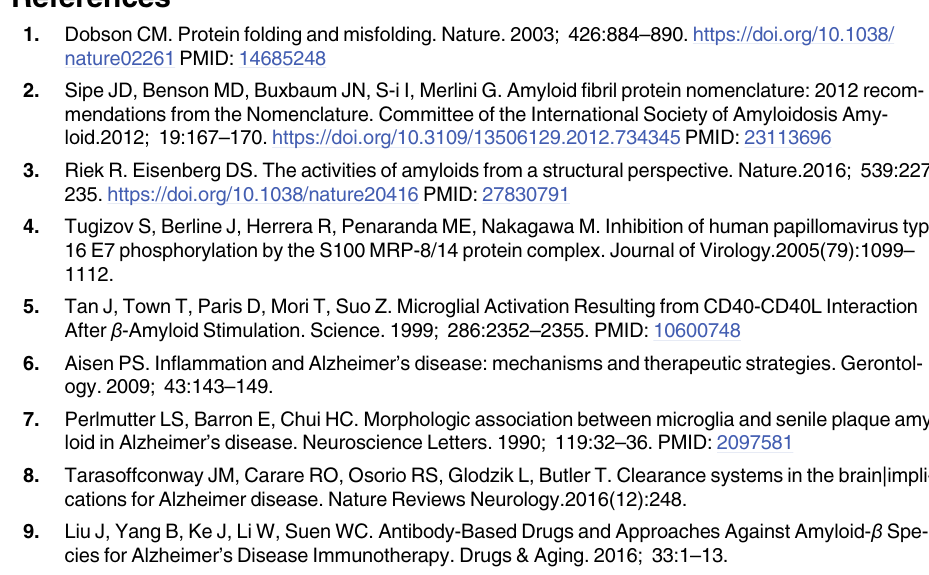
culture medium (left), 400 μ M OA (middle), and 4 μ M HEWL and 400 μ M OA (right)